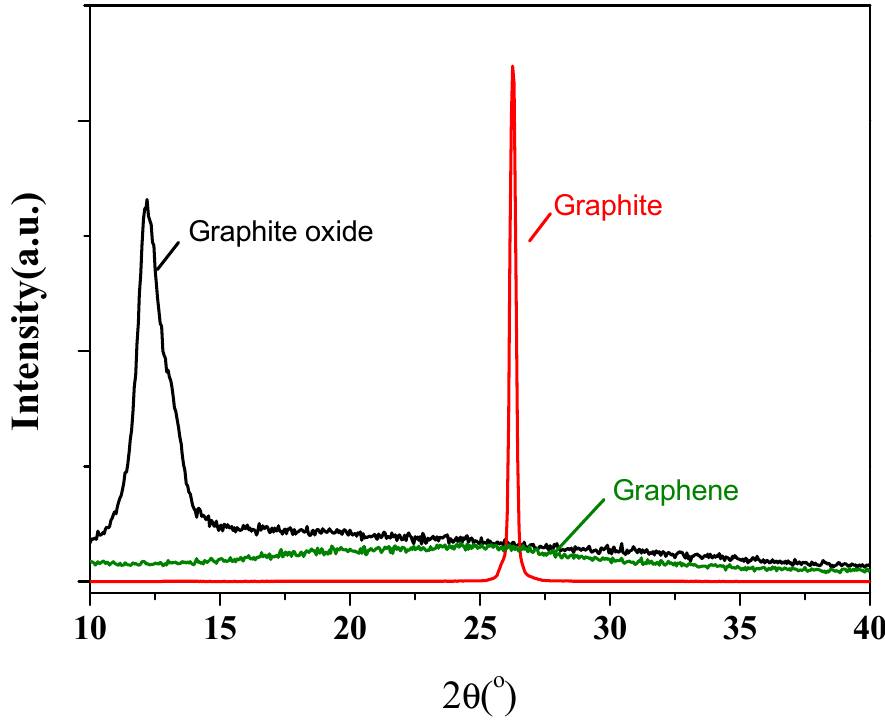
Figure 1. XRD results for natural graphite, Staudenmaier GO and graphene. To find the best filler content for our anticorrosion coating, samples of epoxy with 0, 0.01, 0.05, 0.1 and 0.5 wt.% of GN (reduced at 1100 ◦ C) were prepared and tested. Figure 2 shows the potentiodynamic polarization curves for epoxy coatings added with various